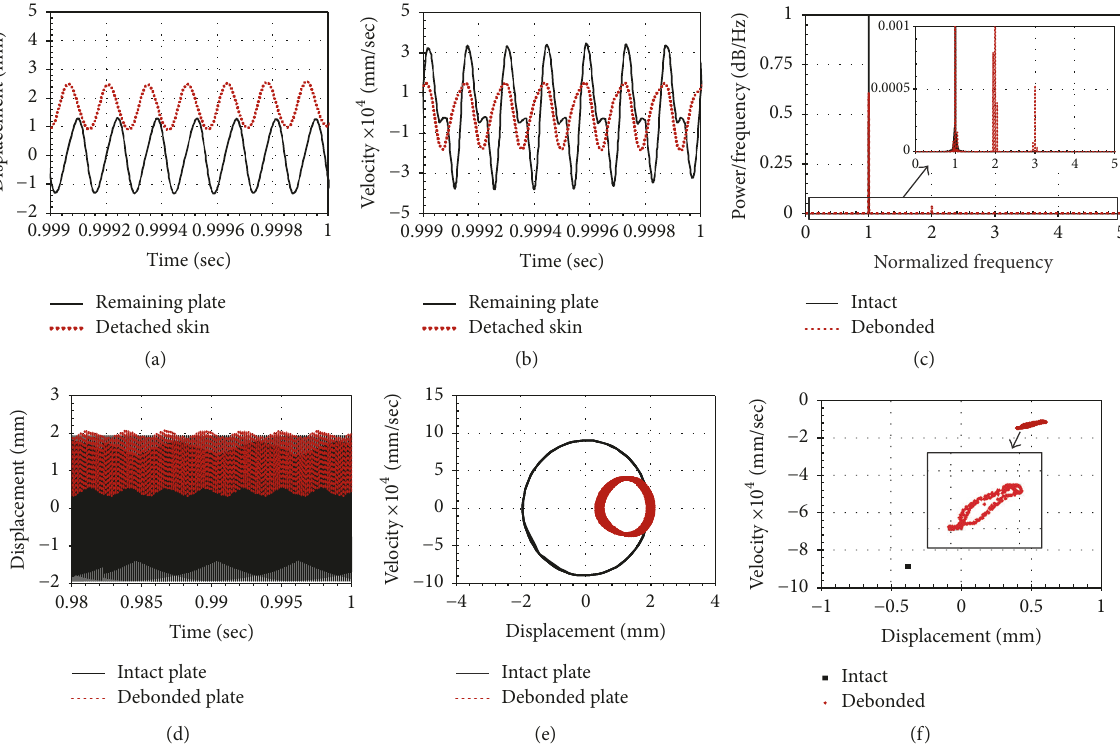
Figure 28: Steady-state dynamic response at 𝜂 = 7 (Ω = 7000 Hz ) : ((a)-(b)) displacement and velocity time histories at points N2 and N3; (c) frequency spectra of the displacement signals at point N1; (d) displacement time histories at point N1; (e) phase portrait at point N1 [80]; and (f) Poincar´e section at point N1